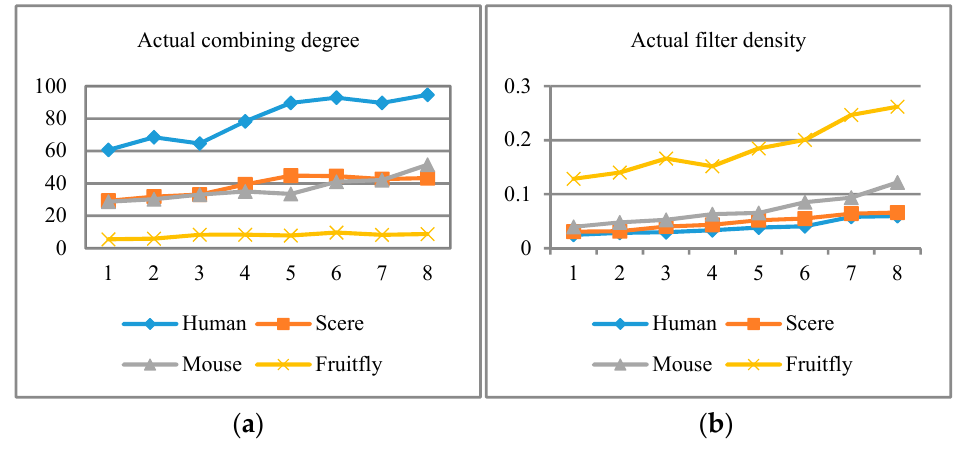
Figure 5. ( a ) Actual combining degree in each threshold; ( b ) actual filter density during the experiment.